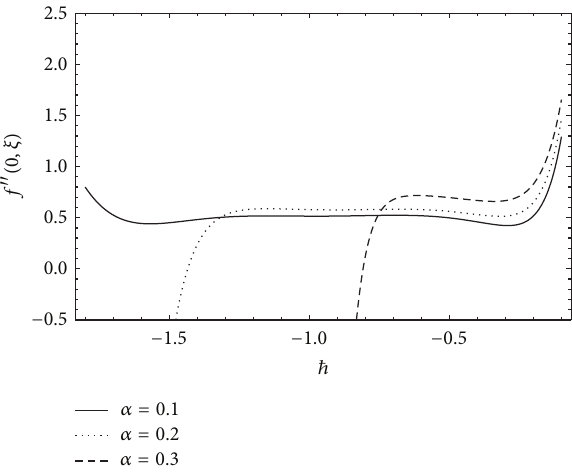
Figure 1: ℎ -Curve for different values of the Deborah number 𝛼 at the 19 th order of